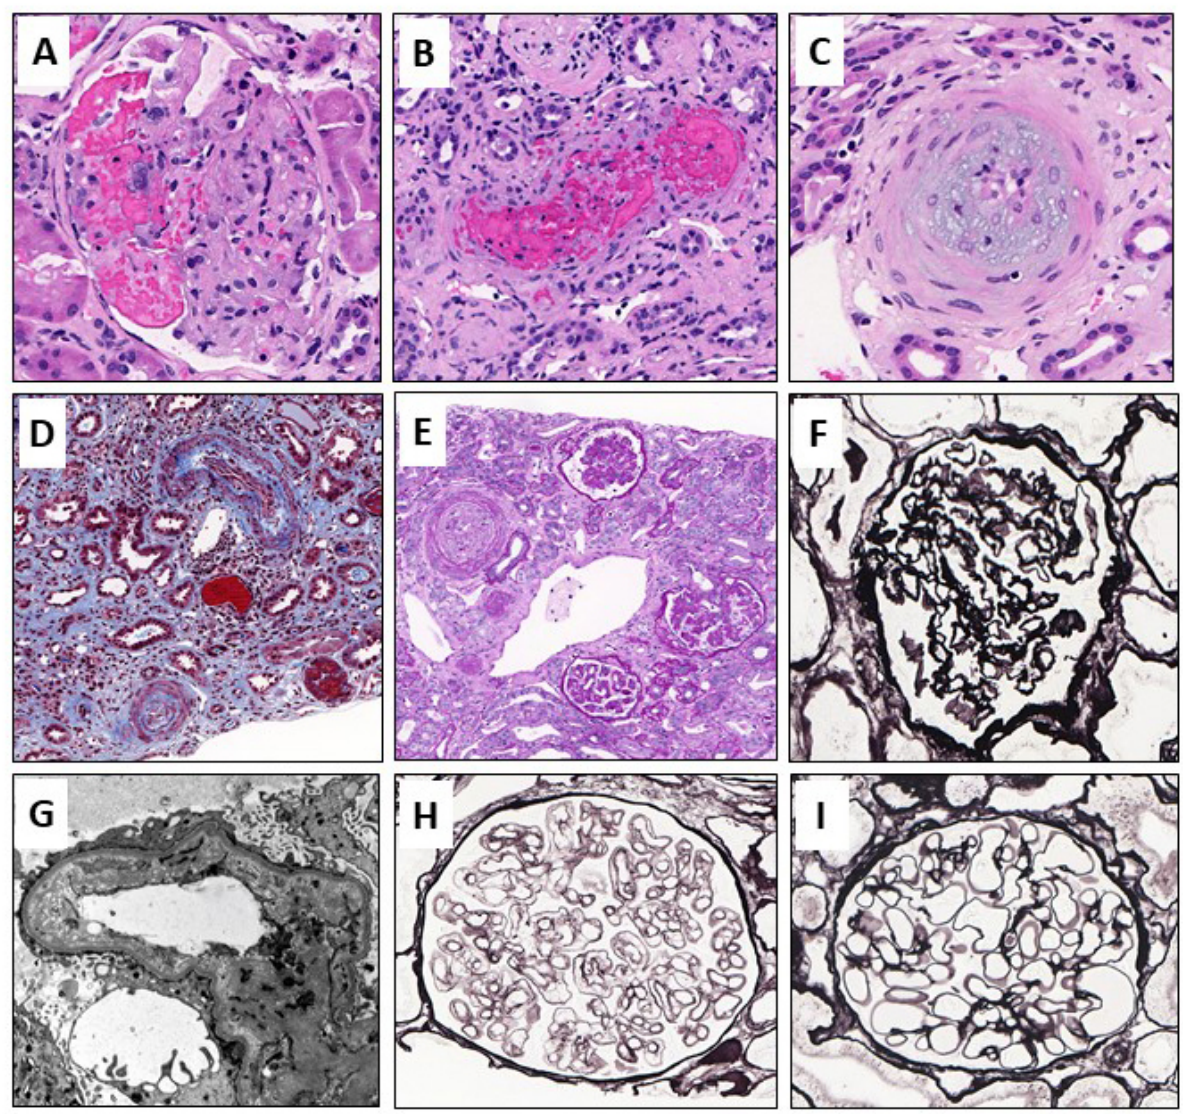
Figure 2. Illustrations of acute, subacute, and chronic TMA changes: ( A ) In acute and active TMA can be seen microaneurysms and intracapillary thrombi, although they are rather rare; ( B ) Thrombi can be seen also in the small arterioles; ( C ) Often there is endothelial injury that causes accumulation of fluffy, myxoid material underneath the endothelium causing occlusion of the vessel; ( D ) Eventually, the vascular injury becomes organized and forms “onion skin”-like appearance. Surrounding interstitial tissue becomes scarred and tubular epithelium is injured; ( E , F ) Vessel occlusion causes ischemic injury to the glomeruli. The basement membrane is wrinkled; ( G ) Electron micrograph of the capillary loop that has endothelial injury shown as electron-lucent material underneath endothelium; ( H ) Ongoing, smoldering endothelial injury causes remodeling of the basement membrane and duplicates become visible even in light microscopy; ( I ) Normal glomerulus with thin and intact basement membranes for comparison to previous ones. Original stainings and magnifications: ( A – C ) Hematoxylin-eosin and 400 × , 200 × , and 400 × , respectively, ( D ) Masson Trichrome 200 × , ( E ) Periodic-Acid-Schiff 200 × , ( F , H , I ) Jones Methenamine Silver, 400 × for all, ( G ) uranyl acetate 12,000 × Histological findings are summarized in Table 5. Myxoid swelling was observed in 9/15 (60%) c-TMA and only in one (6.7%) h-TMA patient ( p = 0.005). Onion-skinning was